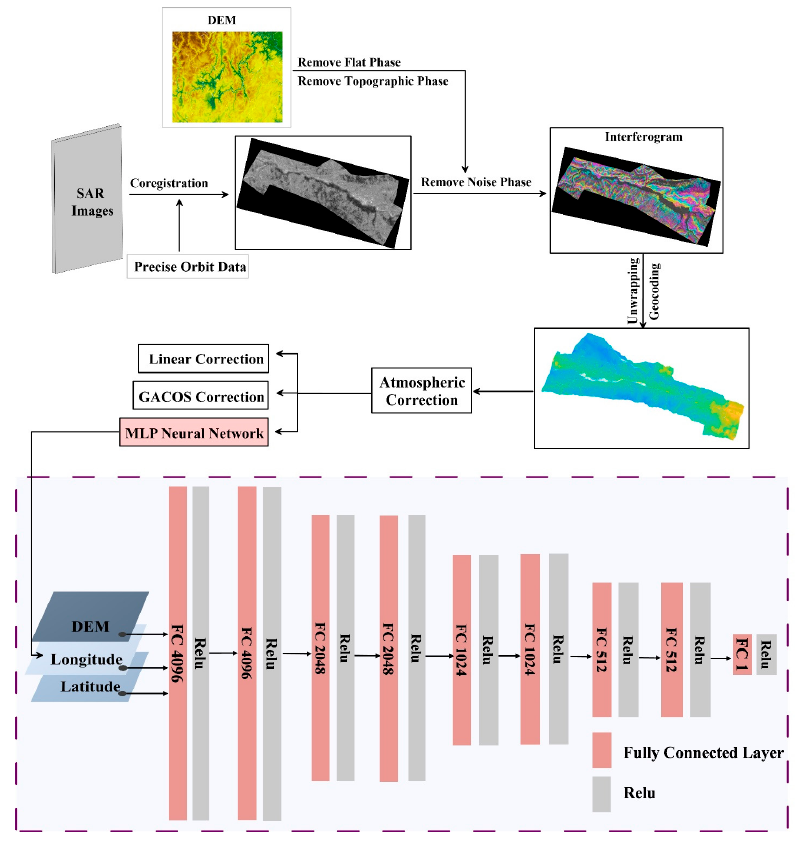
Figure 2. Flowchart of the proposed method.